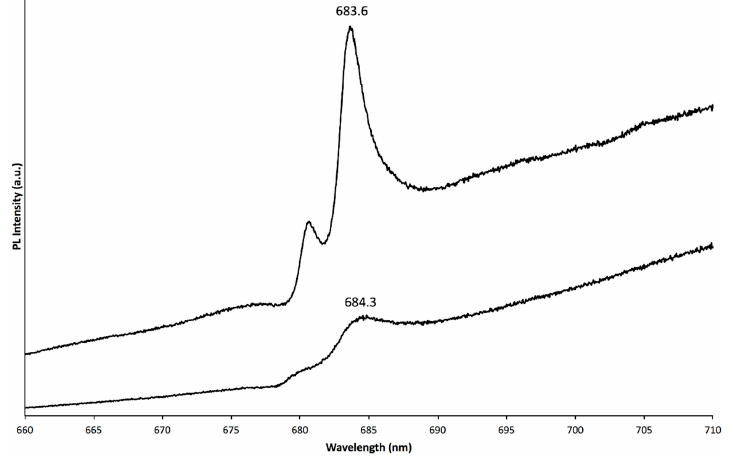
Figure 26. PL spectra from 660 to 710 nm of an emerald from Colombia (upper spectrum) and an emerald from Zimbabwe (bottom spectrum). Note that the upper spectrum is shifted higher for clarity.